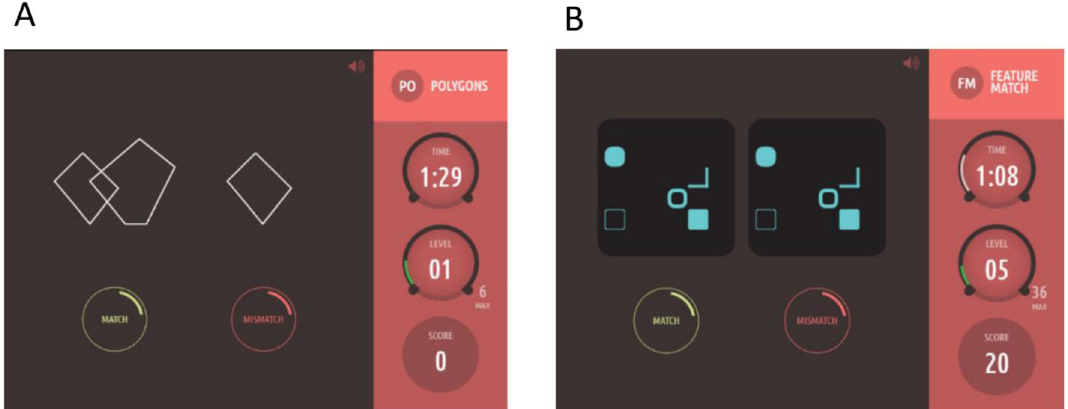
Figure 1. Overview of Cambridge Brain Sciences visual perception tasks. ( A ) Task 1: Interlocking polygons. ( B ) Task 2: Feature match. Participants were instructed to indicate whether a scene displayed on the other side of the screen is identical (“match”) or not identical (“mismatch”) to the other scene. Participants were given 90 s to complete as many trials as possible, with a timer and the score displayed on one side of the